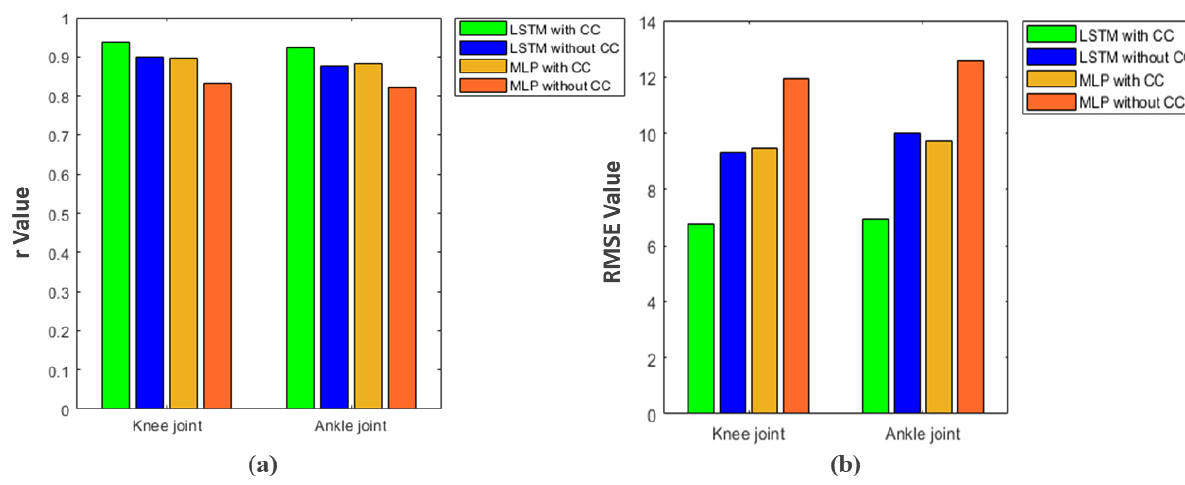
Figure 8. Full Data Prediction with LSTM Network; ( a ) Knee Joint ( b ) Ankle Joint.